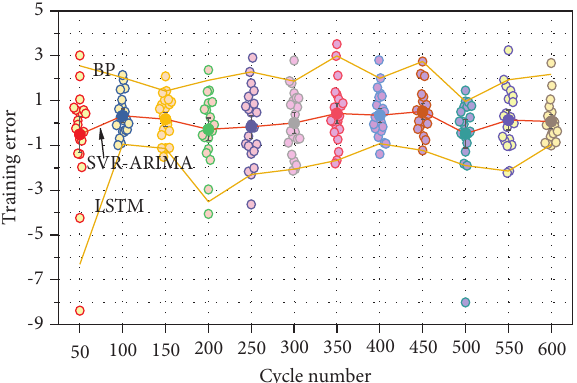
Figure 8: Training error of SVR-ARIMA model compared with the reference model in the classification